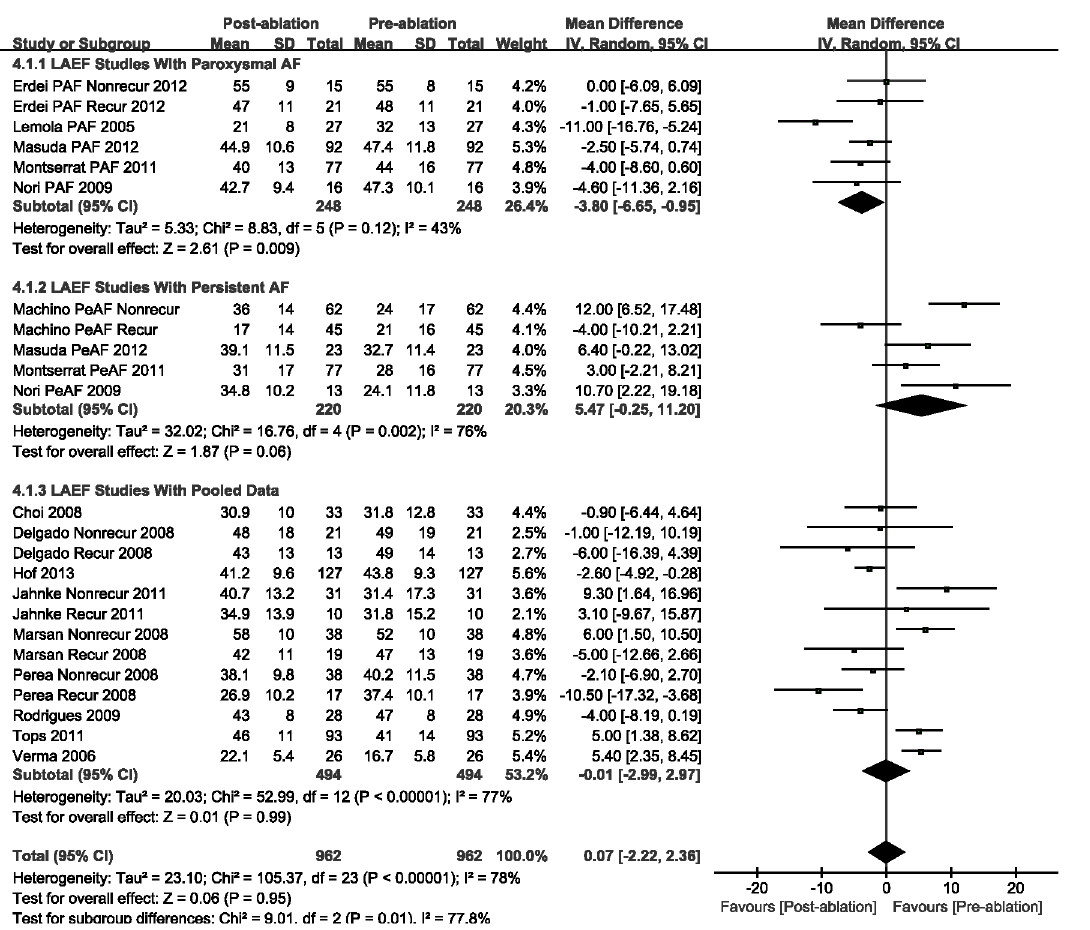
Fig 5. A forest plot of comparison: changes in left atrial ejective fraction (LAEF) pre-ablation and post-ablation.